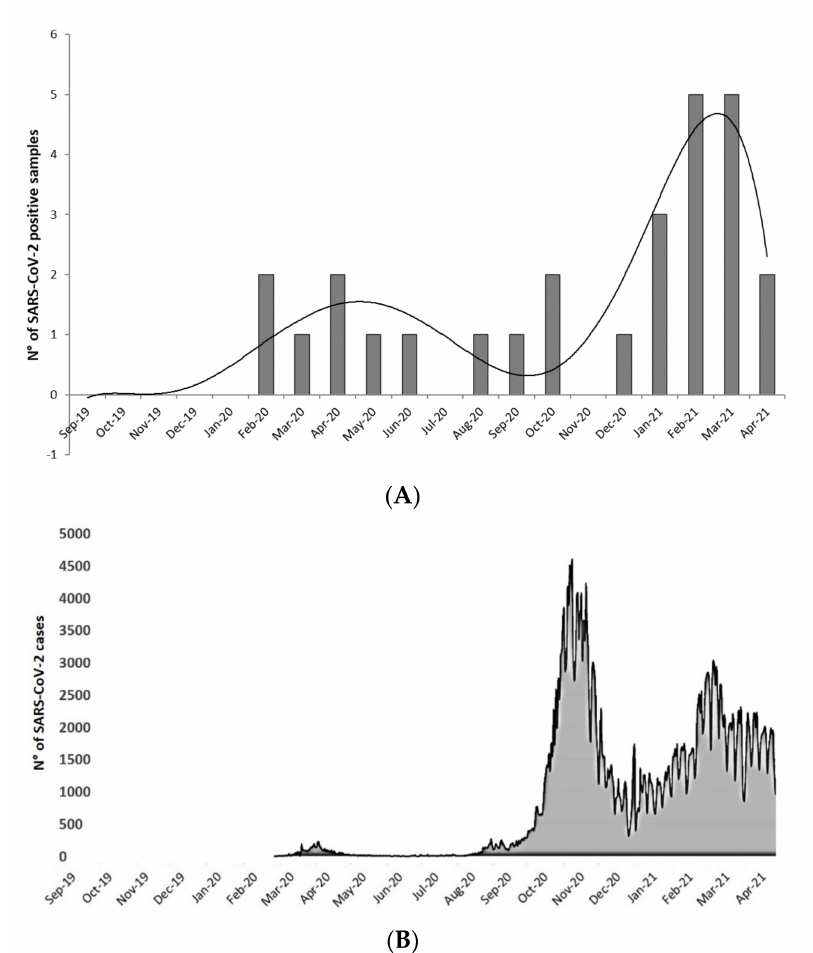
Figure 2. ( A ) Trend of SARS-CoV-2 detection in bivalve mollusks samples included in the moni- toring (September 2019 to April 2021). ( B ) SARS-CoV-2 infection trend (daily new cases in Cam- pania region residents from September 2019 to April 2021. Modified from Ministry of Health; https://public.flourish.studio/story/722265/) (accessed on 23 July